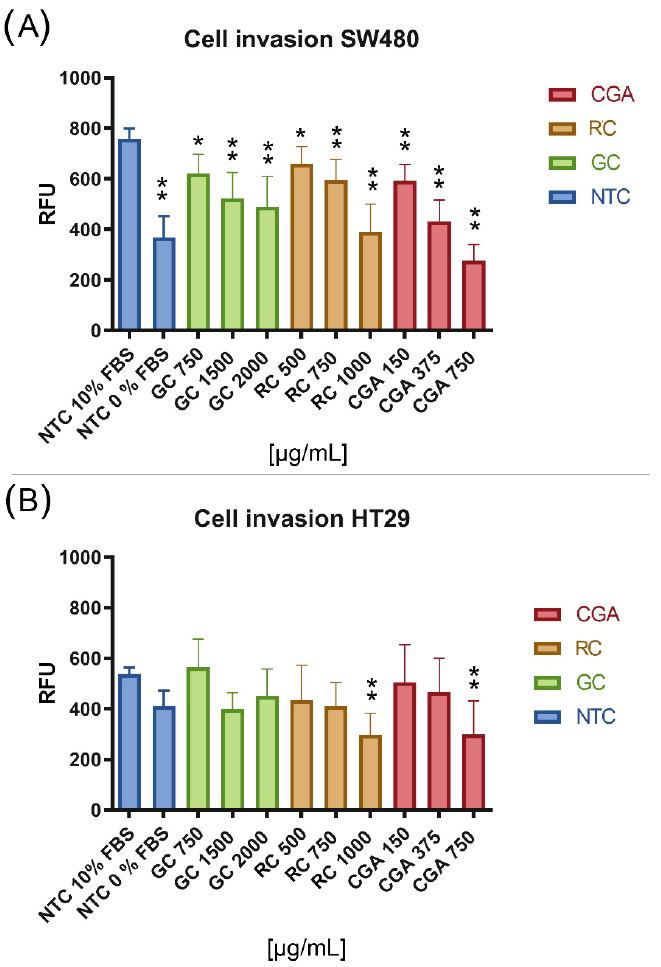
Figure 4. The inhibition of the invasion process of SW480 ( A ) and HT-29 ( B ) cell lines. The percentage of relative fluorescence units (RFU) is proportional to the number of invasive cells. FBS 10% was used as a chemoattractant control and treatment exposure was 24 h. Values are expressed as the mean ± SEM of three independent experiments. Two-way ANOVA, the difference to non- treated cells, * p ≤ 0.05 and ** p ≤ 0.01. 3.5. Top/Fop Flash Assay To determine if the treatments had an impact on the regulation of transcriptional activity of the Wnt/ β -catenin pathway, HT-29, and SW480 cells were transfected with the TOP/FOP Flash reporter plasmid and treated with subtoxic doses of GC (1500 µg/mL), TC (750 µg/mL), and CGA (375 µg/mL) for 24 h. As controls of the regulation of the Wnt pathway, doses lower than the IC50 were employed. For positive and negative regula- tion of the pathway, the selective inducer CHIR 99021 (10 µM) and the selective inhibitor iCRT14 (40 µM) were included in the experiments. As we expected, the results in SW480 cells (Figure 5A) show a substantial effect on the induction of pathway activation with CHIR, while the inhibition effect of the transcriptional activity of the pathway by iCRT14 is significant compared to the NTC condition. Treatments with GC and TC did not have significant differences in the regulation of the pathway, while CGA had a comparable ef- fect with the selective inhibitor. In the case of HT-29 cells (Figure 5B), the effect of the